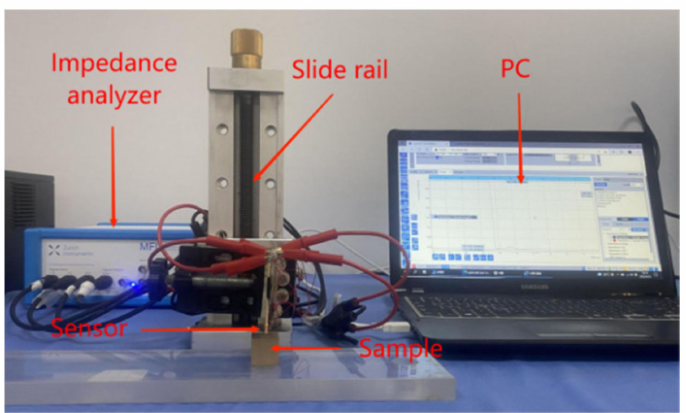
Figure 6. Experimental